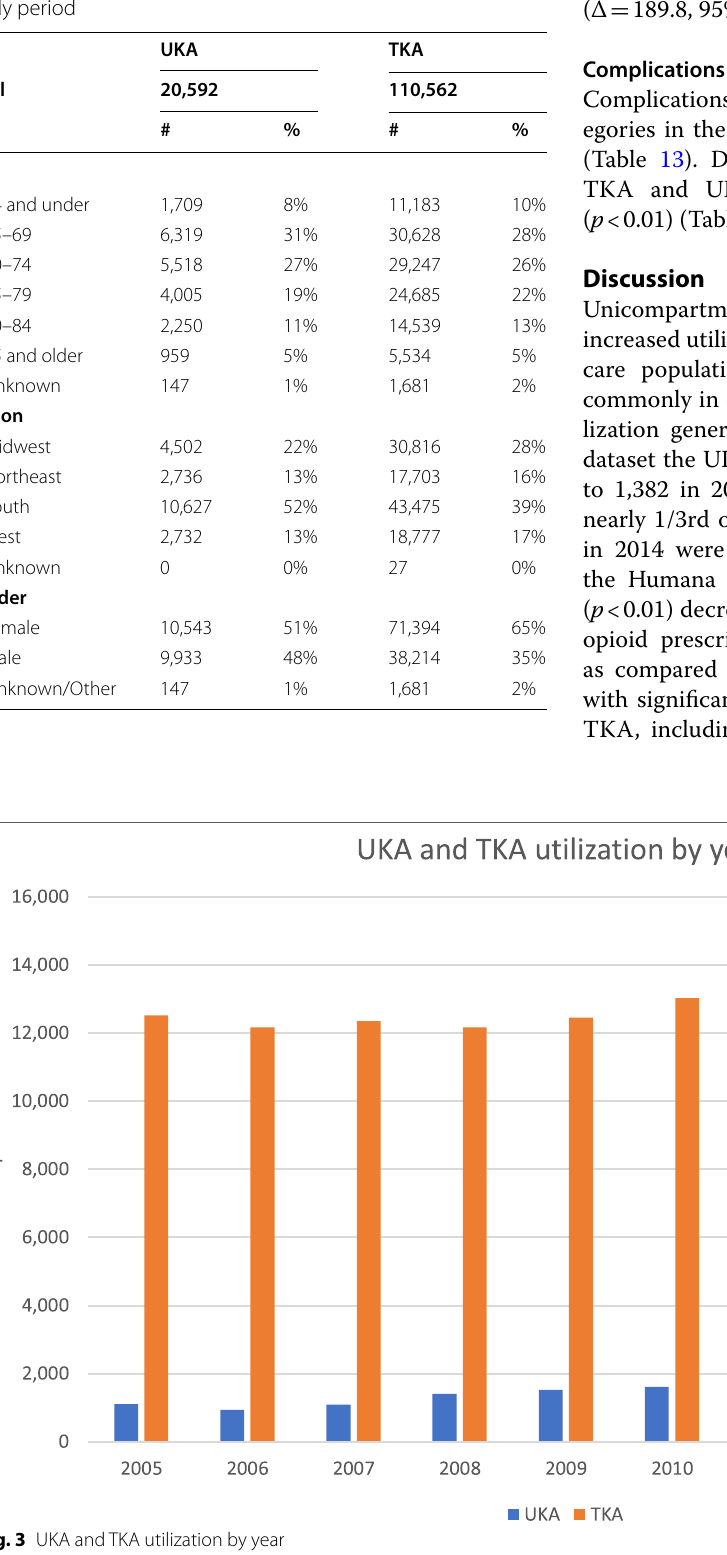
Table 8 All patients who underwent UKA and TKA during the